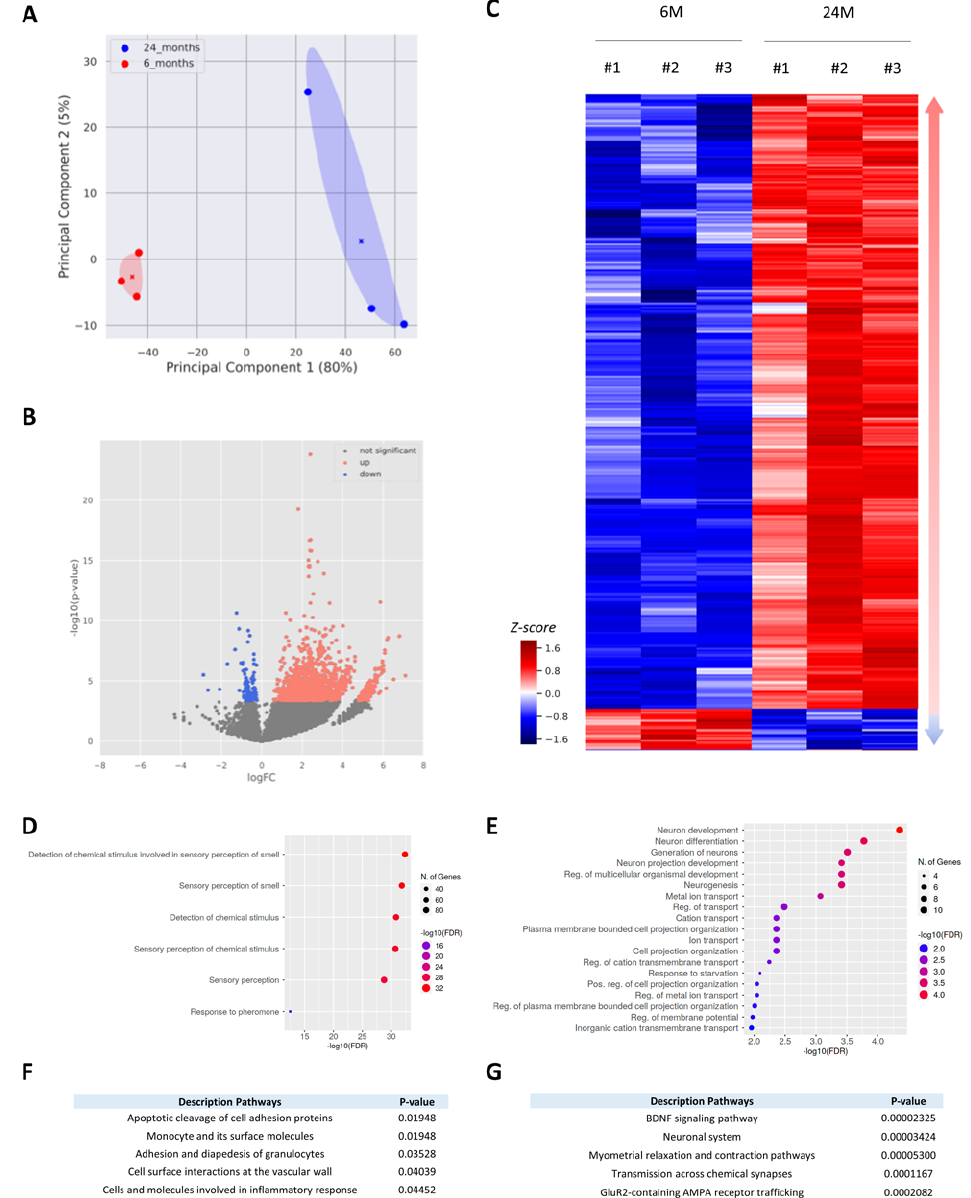
Figure 2. Age-related changes in the transcriptome signature of the cerebral cortex. ( A ) Principal component analysis (PCA, explaining 85% of the variance in total) for the gene expression of 6-month-old (red) and 24-month-old (blue) cortices (n = 3 per age group). The cross represents the centroid for each sample set. ( B ) Volcano plot of differentially expressed genes, mapping the 400 up-regulated genes (red) and 27 down-regulated genes (blue) at a 1% FDR. FC, fold change. ( C ) Hierarchical clustering of genes showing significant differential expression between 6- and 24-month-old cortices. Red and blue indicate relatively higher and lower expression, with genes independently scaled to a mean of zero. ( D , E ) Gene Ontology analysis of up-regulated ( D ) and down-regulated ( E ) genes using the ShinyGO tool (version 0.76.1). The pathway database used was the GO Biological Process. Parameters were set at a 0.05 FDR cut-off with no redundancy in GO terms. ( F , G ) Pathways enriched among up-regulated ( F ) and down-regulated ( G ) genes using the BioPlanet 2019 pathway database. Pathways are sorted by p-value